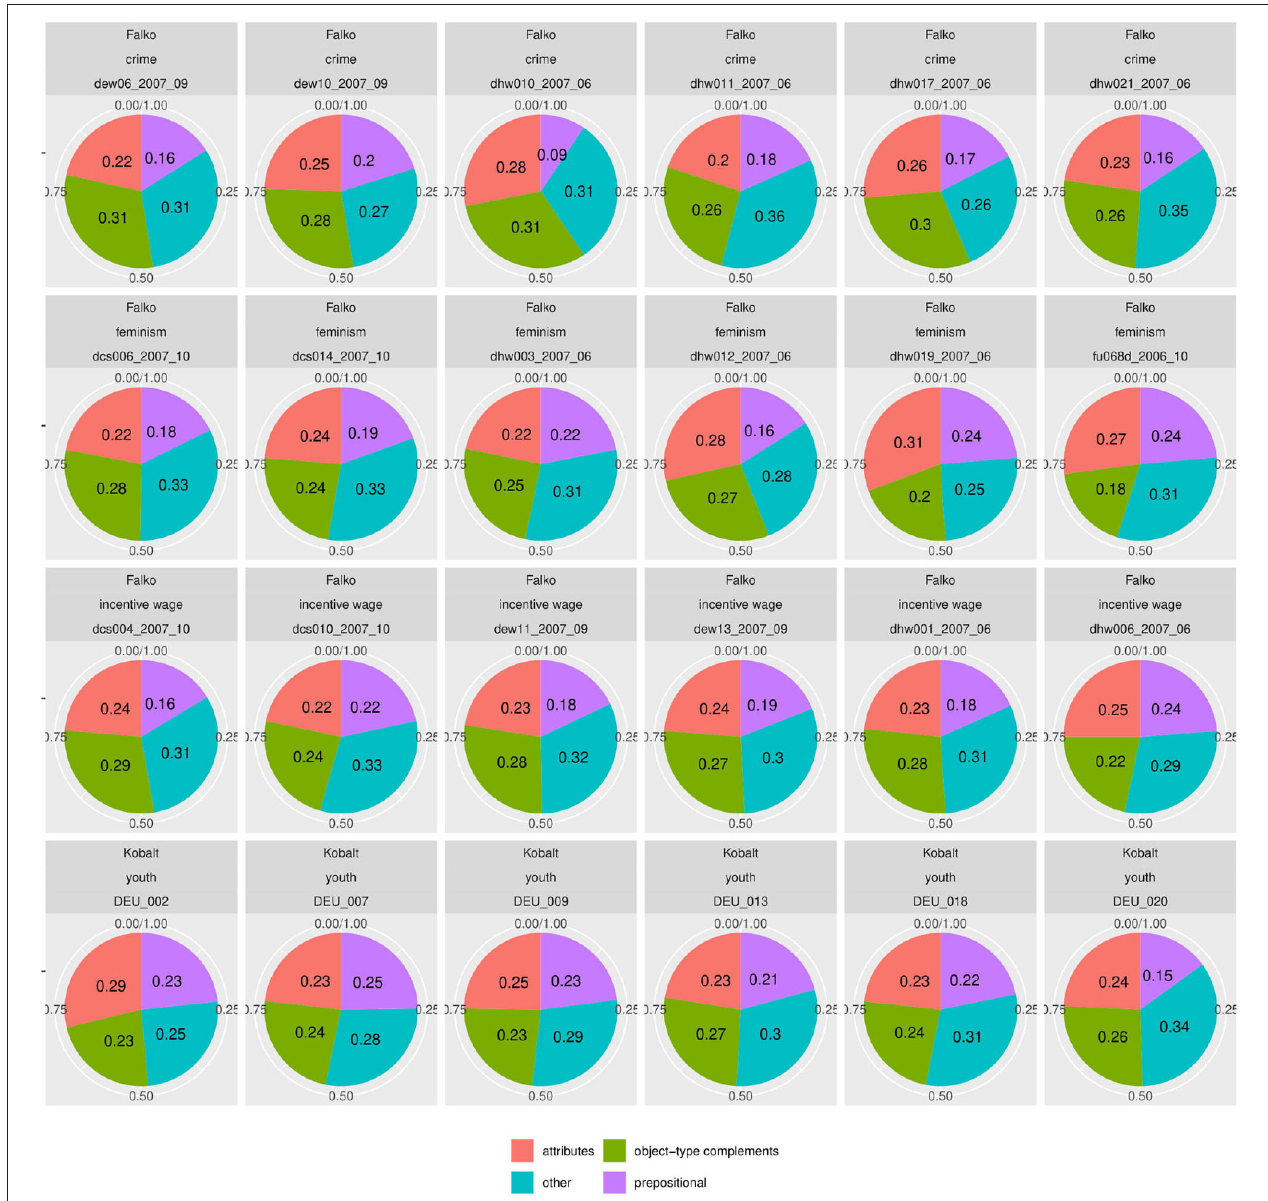
FIGURE 10 | Individual distributions of frequent dependencies in Falko and Kobalt documents. Dependencies included: adverb and attribute (attributes), prepositions in free PPs and prepositional objects, nominal complements to PPs (prepositional), subjects, predicates, accusative and dative objects (object-type complements), determiners, lexical, and auxiliary verbs (other). Proportions of dependency types to one another are much more homogeneous than morphological subclasses of elements. One exception is dhw_010_2007_06 (3rd from the left in top row), which contains only 9% of prepositional dependencies (prepositions and nominal complements to